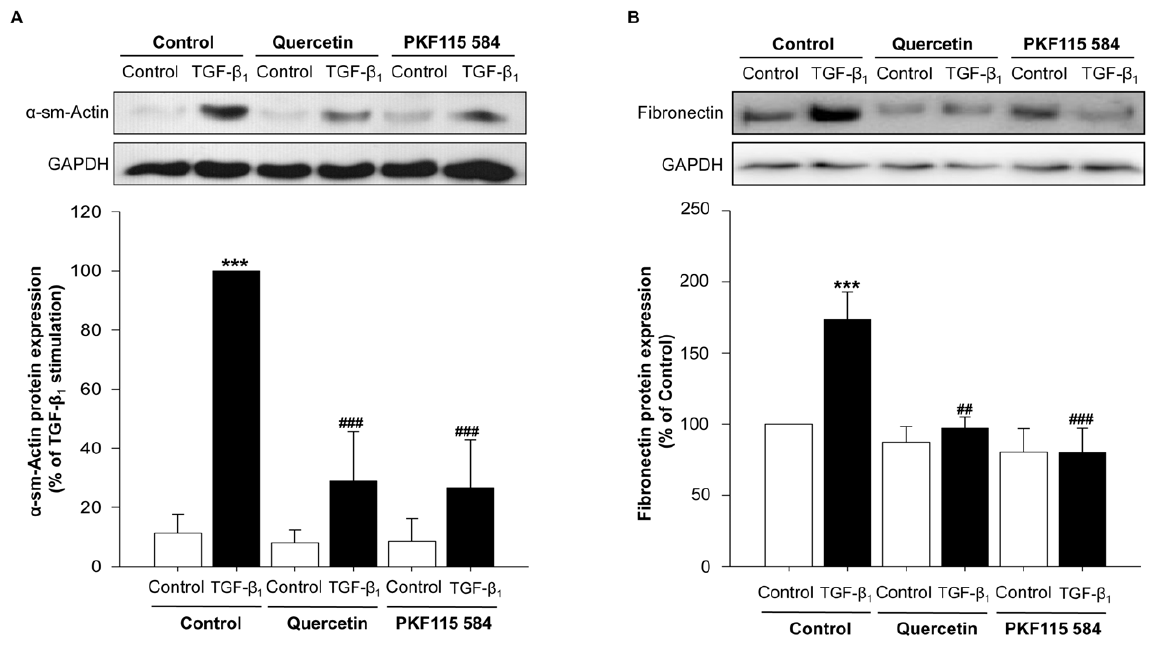
Figure 6. Pharmacological inhibition of b -catenin attenuates TGF- b 1 -induced a -sm-actin and fibronectin expression. Pharmacological inhibition of b -catenin/TCF 4 signaling by quercetin or PKF115–584. Confluent MRC-5 lung fibroblasts were treated with TGF- b 1 (2 ng/ml) for 48 h in the absence or presence of either quercetin (40 m M) or PKF115–584 (100 nM). Expression of a -sm-actin (A) and fibronectin (B) was evaluated by immunoblotting using a specific antibody. Responses were quantified by densitometry and normalized to the expression of GAPDH. Data represent mean 6 s.e.m. of 3 independent experiments. ***p , 0.001 compared untreated MRC-5 lung fibroblasts (control), ## p , 0.01; ### p , 0.001 to TGF- b 1 treated MRC-5 lung fibroblasts determined by a one-way ANOVA followed by a Newman-Keuls multiple comparison